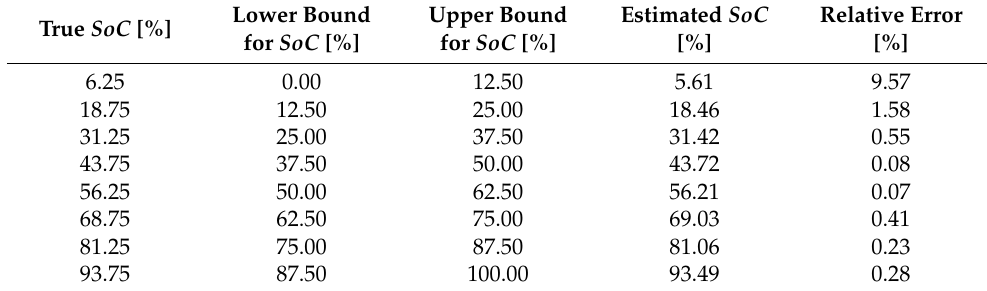
Table 3. Results of SoC